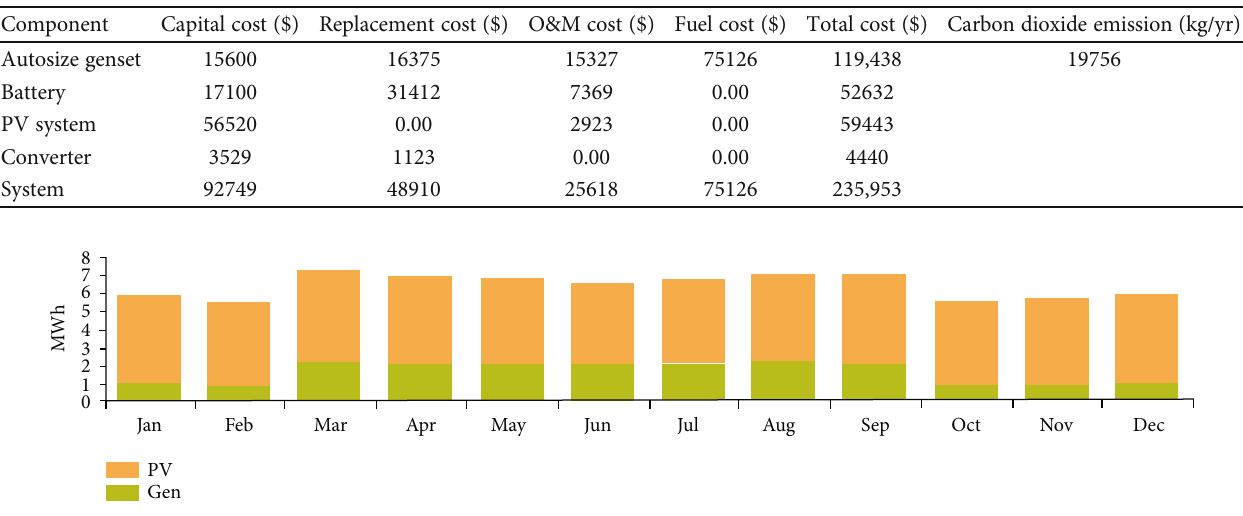
Figure 10: Monthly average electricity production of the hybrid PV/diesel system with battery for the secondary